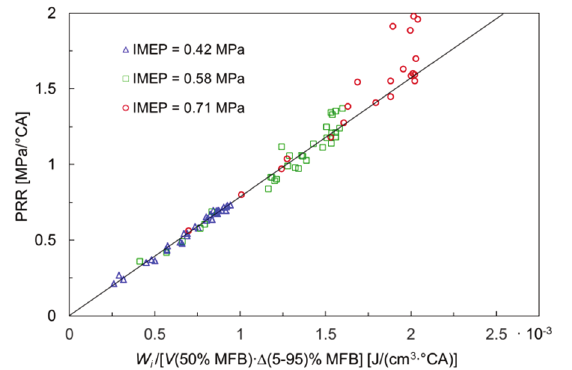
Fig. 7. Pressure rise rates as a function of the indicated work divided by combustion duration and volume at 50% MFB for all investigated condi-